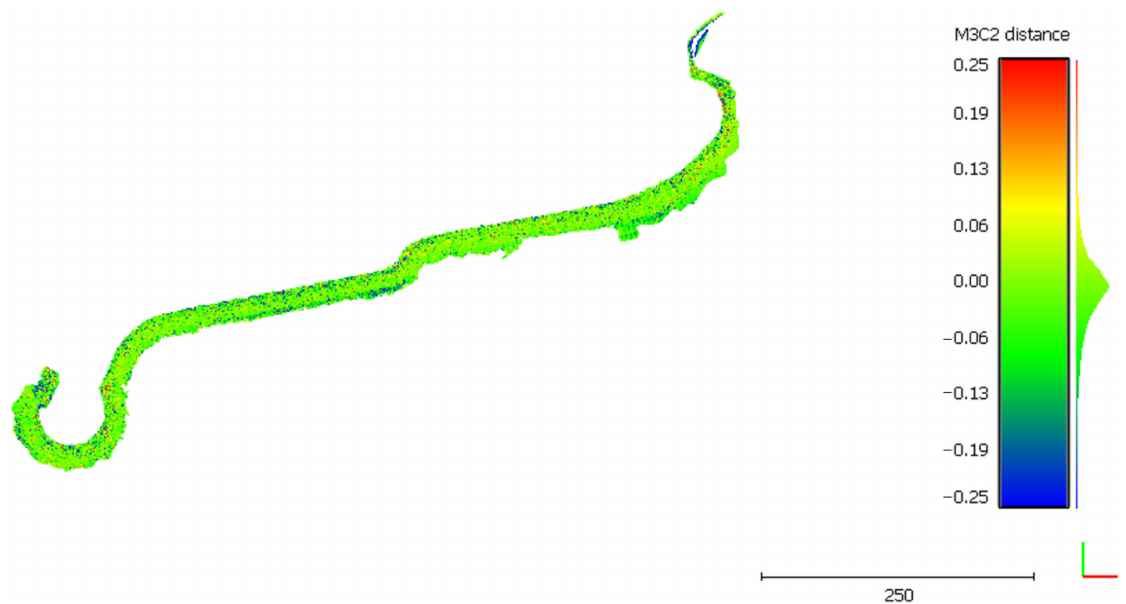
Figure 9. Comparison between DSM 1 (reference) and DSM 2 (compared) on the submerged breakwater, with distance values limited within the interval ( − 0.25; 0.25)